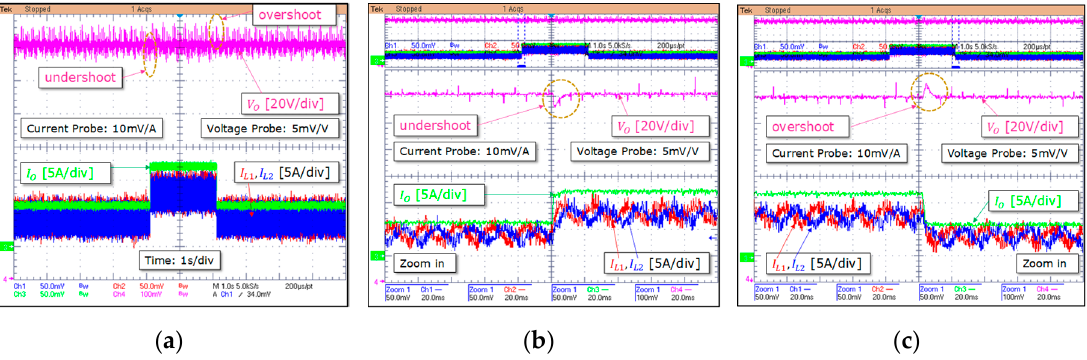
Figure 18. Experimental waveforms for optimized controllers at V in = 70 V, V O = 140 V, R O = 25 Ω /12.5 Ω , ( a ) overview when 100% load change, ( b ) zoom-in waveforms for positive load change, ( c ) zoom-in waveforms for negative load change.